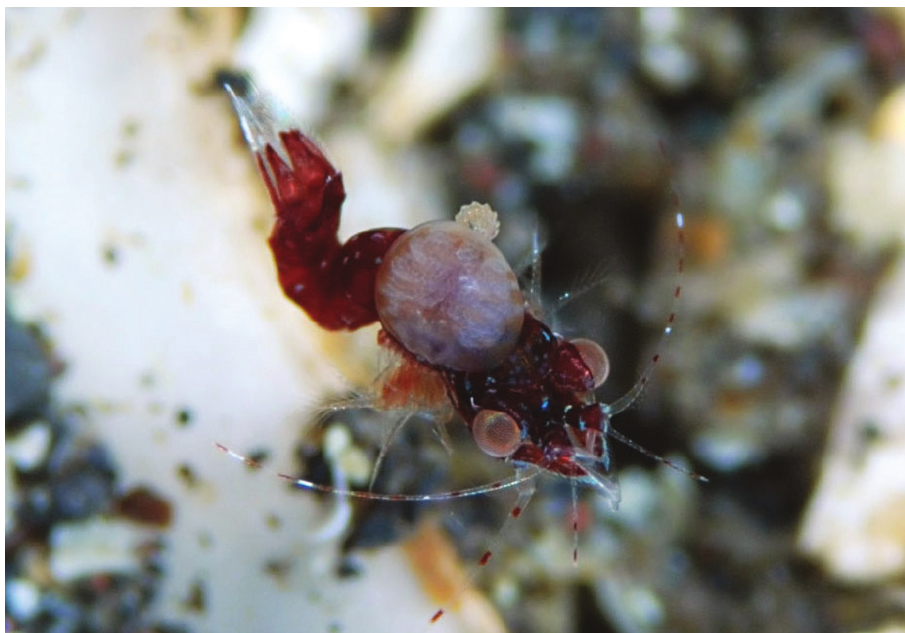
Figure 1. A female and male of Aspidophryxus izuensis sp. n. on the carapace of the mysid Mysidella ho- shinoi , Akino-hama, Izu-Oshima Island, Sagami Sea, Japan, 1 January 2015, 35 m depth, habitus in situ, photographed by O.